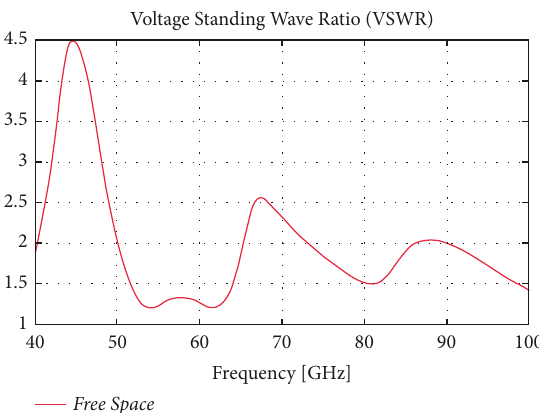
Figure 12: VSWR curve of the 1 × 2 antenna array.